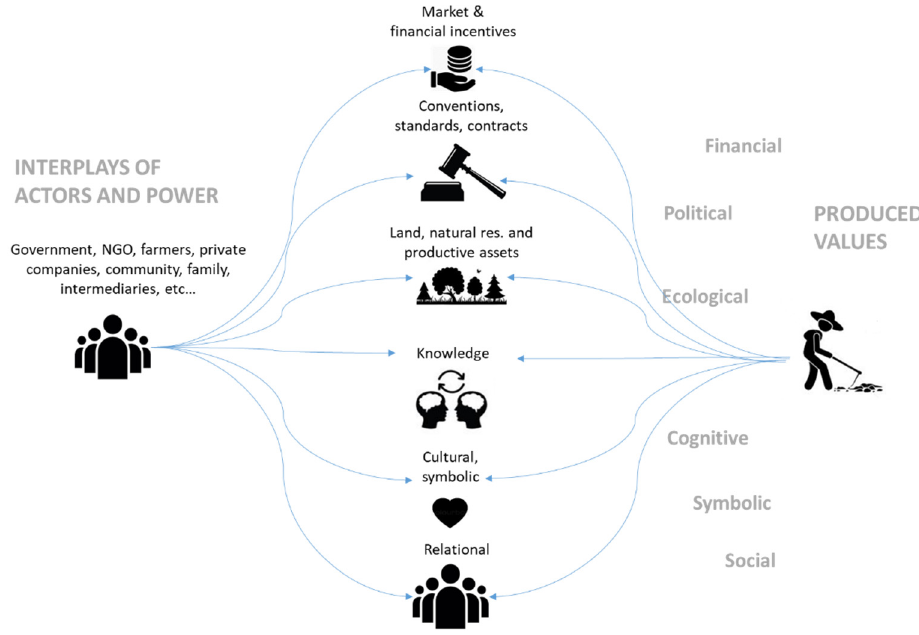
Figure 1. Channels of labour control and their indirect links to surplus values.